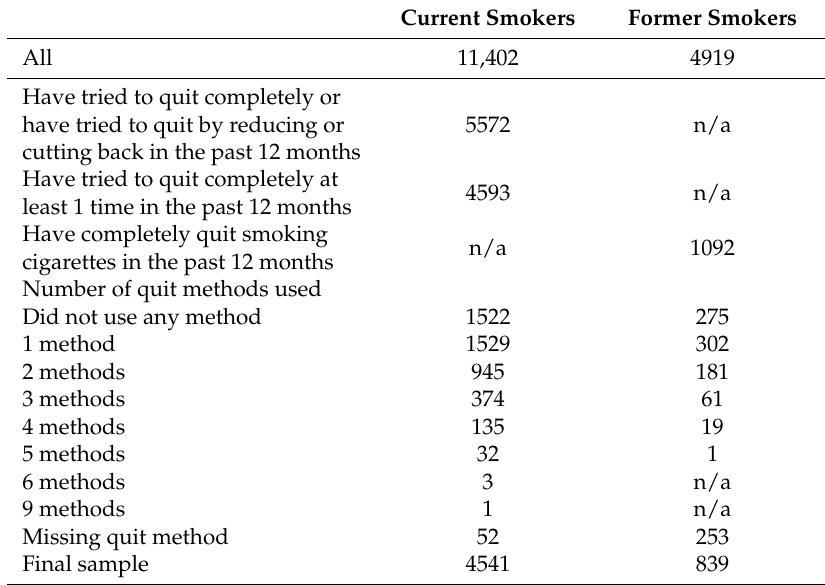
Table 1. Quit methods used in the past 12 months by current and former smokers, Population Assessment of Tobacco and Health (PATH) survey